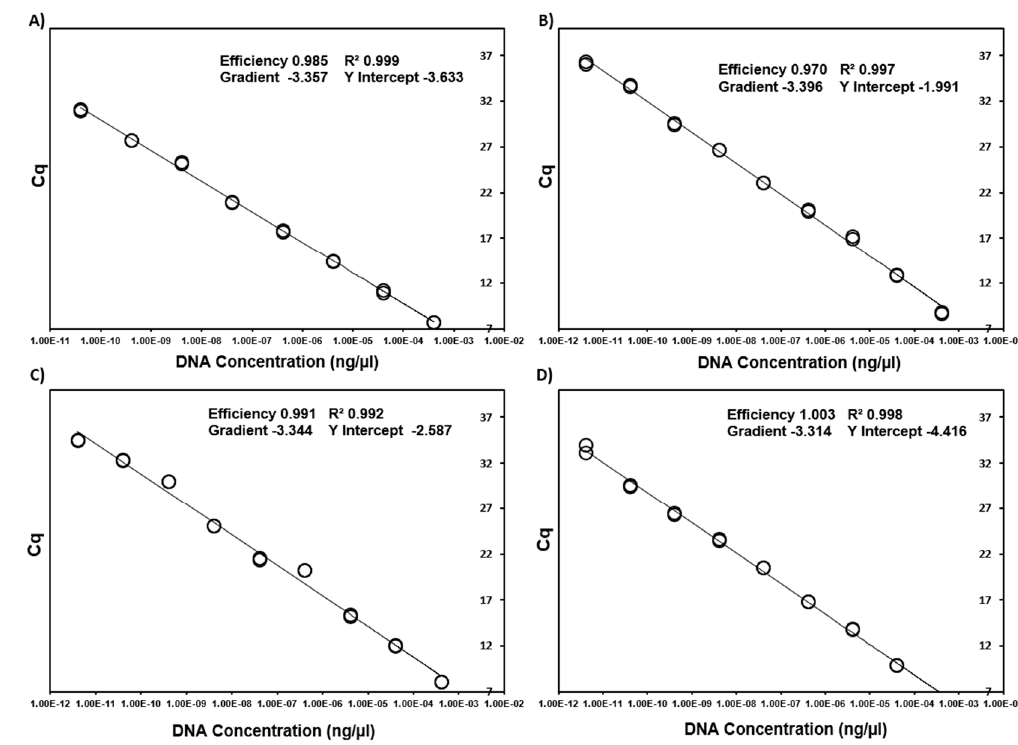
Figure 2. Standard curves generated from 12-fold serial dilutions of target gBlock Gene Fragments for A. platys ( A ), E. canis ( B ), Mycoplasma spp. ( C ) and mammalian mtDNA ( D ).